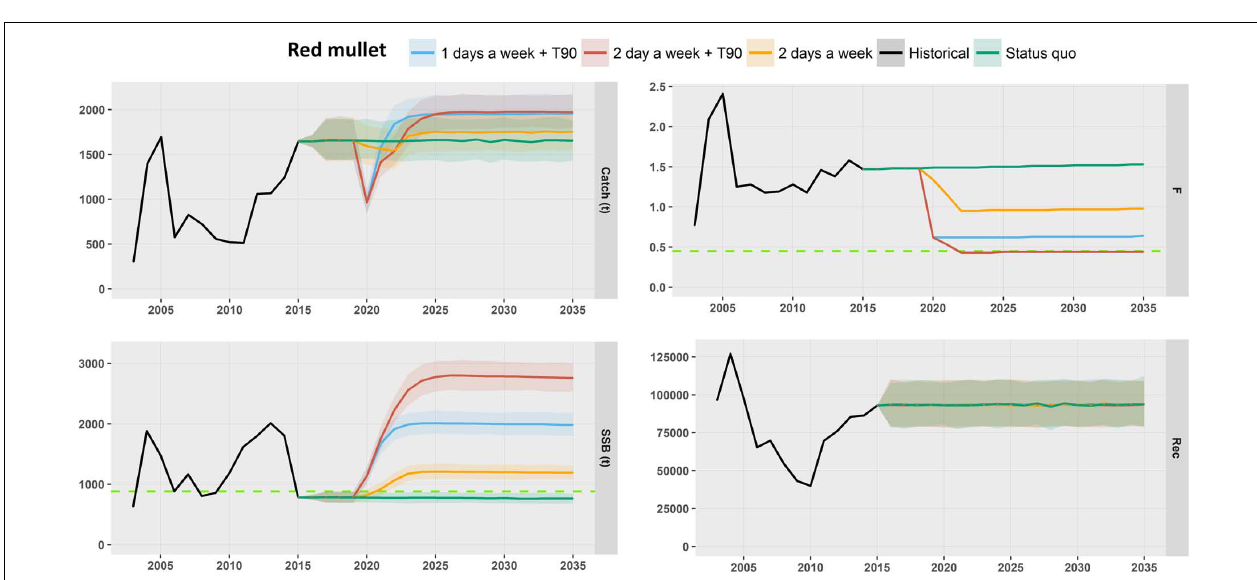
FIGURE 11 | Results of the bioeconomic model of catch (t), effort (average days at sea), profits (M€), and crew wage (€/day) for demersal gillnet fleet (GNS) under Scenario 0: status quo ; Scenario 6: 40% effort reduction; Scenario 7: selectivity change plus 20% effort reduction; and Scenario 8: selectivity change plus 40% effort reduction.